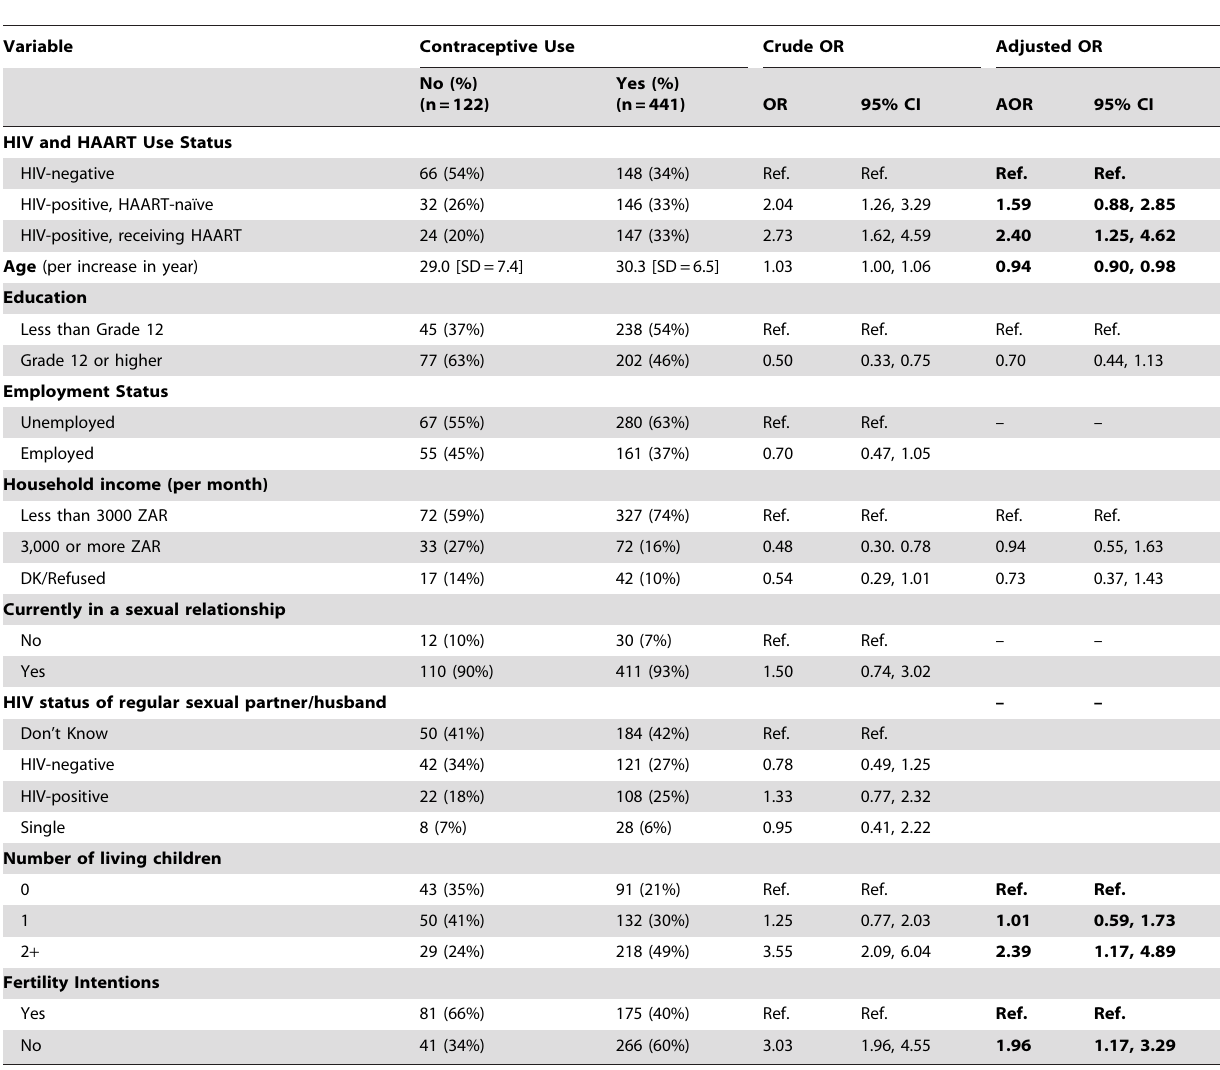
Table 3. Univariate and adjusted analyses of variables associated with contraceptive use among HIV-positive (HAART users and HAART-naı¨ve) and HIV-negative women (aged 18–44 years, currently sexually active and non-pregnant) in Soweto, South Africa